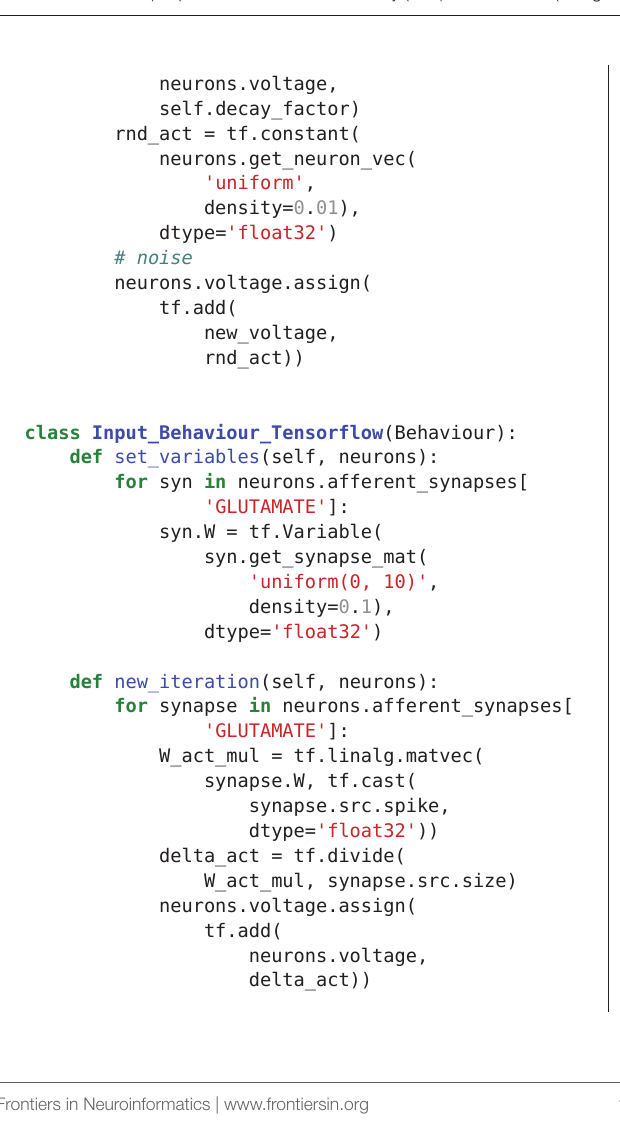
FIGURE 7 | Comparison of processing time (y axis, log scale, seconds) for the described network comprised of different numbers of neurons (x axis, log scale, number of neurons) implemented either with NumPy (blue) or Tensorflow (orange and red) modules. Plotted are the means over 10 runs and their standard deviations.